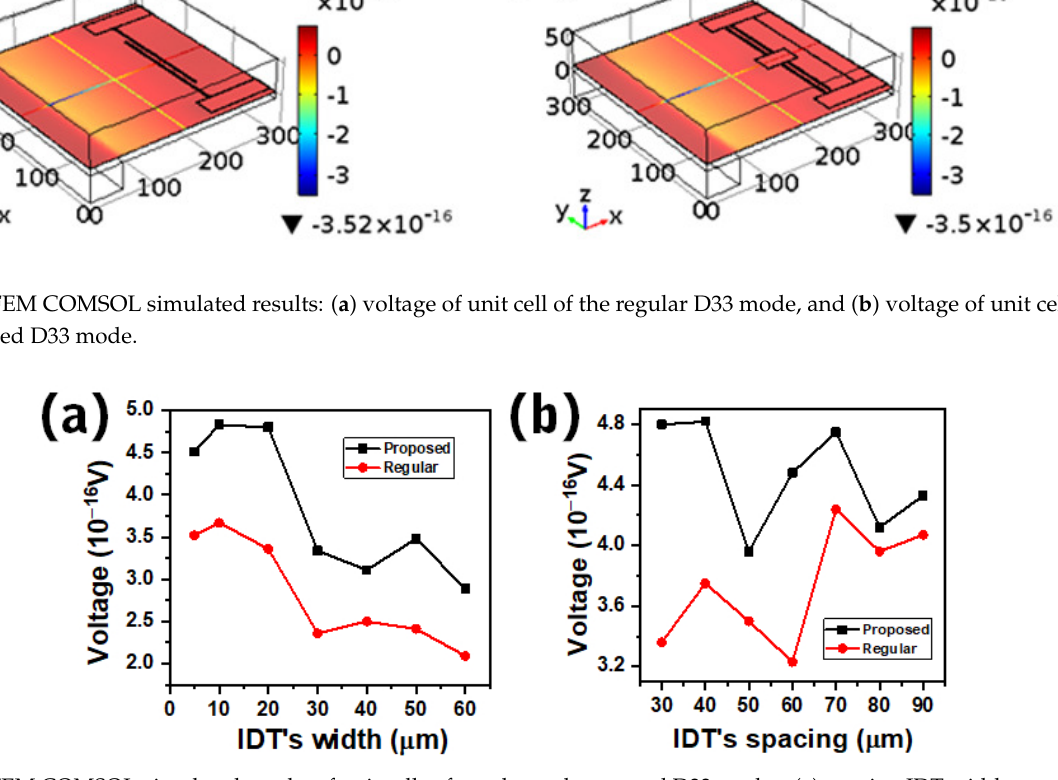
Figure 4. FEM COMSOL-simulated results of unit cells of regular and proposed D33 modes: ( a ) varying IDT widths, and ( b ) varying the spacing between two adjacent IDTs with a 20 µ m